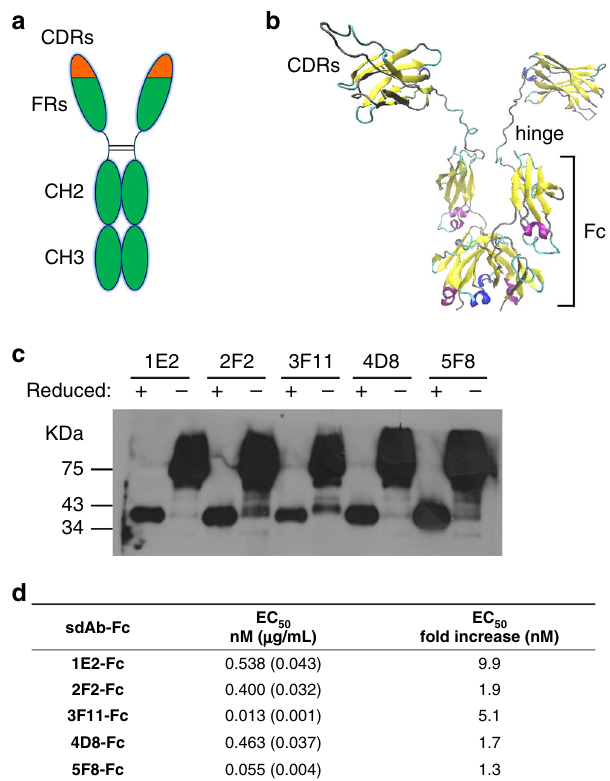
Fig. 4 Inhibition of SARS-CoV-2 entry by Fc-fused sdAbs. a Representation of the human IgG1 Fc-fused sdAbs in this study. SdAb-Fc fusion construction generates a bivalent molecule with an approximate molecular weight of 80 kDa. b Homology modeling of the bivalent 5F8-Fc molecule with SWISS-MODEL server (https://swissmodel.expasy.org) 23 . The template structure for 5F8 modeling was based on a humanized camelid sdAb in the PDB database (3EAK). The structure is depicted as cartoons and colored with secondary structure. Three CDRs, hinge region and Fc were indicated. c Five Fc-fused sdAbs were analyzed by Western blot with gradient SDS-PAGE in reducing (with β -mercaptoethanol) or non- reducing (without β -mercaptoethanol) condition. d Summary of EC 50 value of Fc-fused sdAbs neutralization against SARS-CoV-2pp. EC 50 fold increases versus the corresponding monovalent sdAbs were fl owed over the chip surface. After each cycle, the sensor surface was regenerated with10 mM glycine-HCl pH 2.5. The data were fi tted to a 1:1 interaction steady- state binding model using the BIAevaluation 1.0 software. For competition-binding assays, the ACE2 protein was diluted in 10mM sodium acetate buffer, pH4.5, and was immobilized on the chip at about 650 response units. For the analyses, the His-tagged SARS-CoV-2 RBD protein was diluted in HBS-EP buffer or HBS-EP buffer with 100nM antibody (1E2, 2F2, 3F11, 4D8, or 5F8). The RBD in different buffer at gradient concentrations (0, 6.25nM, 25nM, 100nM and, 400nM) was fl owed over the chip surface. After each cycle, the sensor surface was regenerated with 10mM glycine-HCl pH 2.5. The binding kinetics was analyzed with the software of BIAevaluation using a 1:1 binding model.